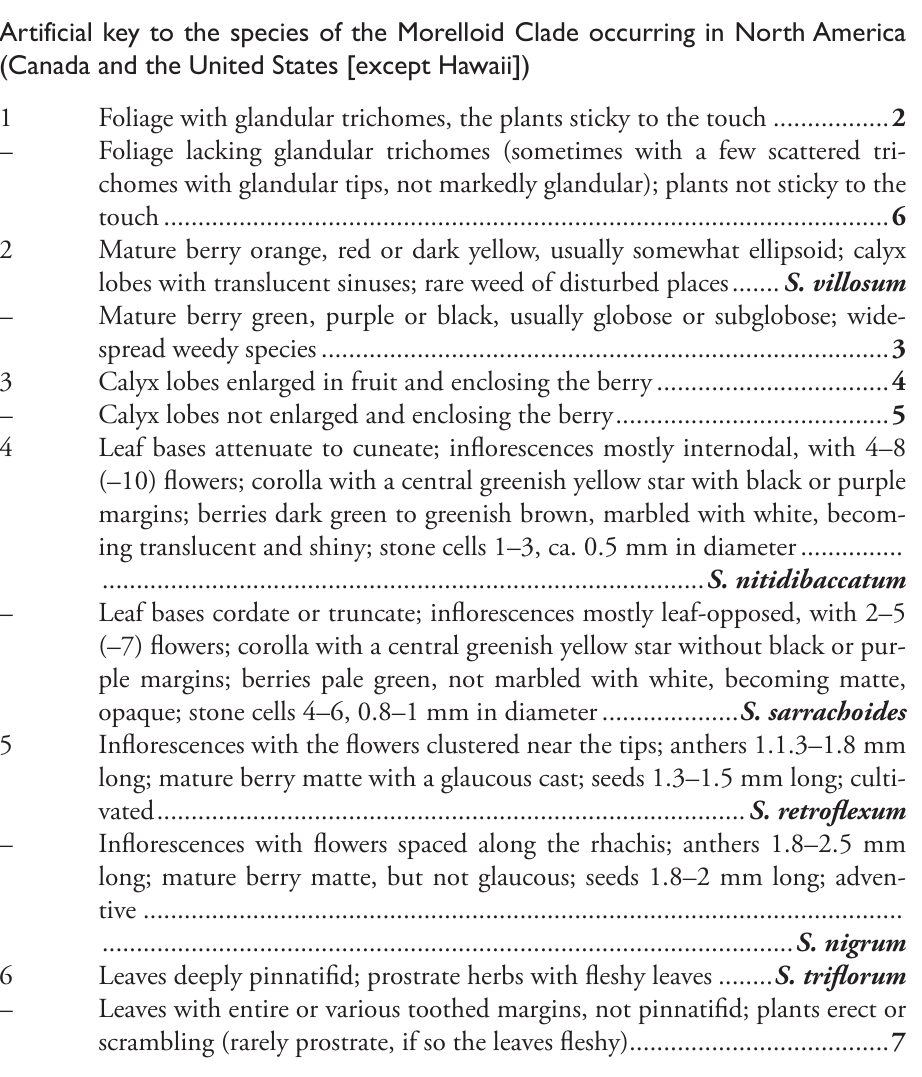
6 Leaves deeply pinnatifid; prostrate herbs with fleshy leaves ........ S. triflorum – Leaves with entire or various toothed margins, not pinnatifid; plants erect or scrambling (rarely prostrate, if so the leaves fleshy) ......................................